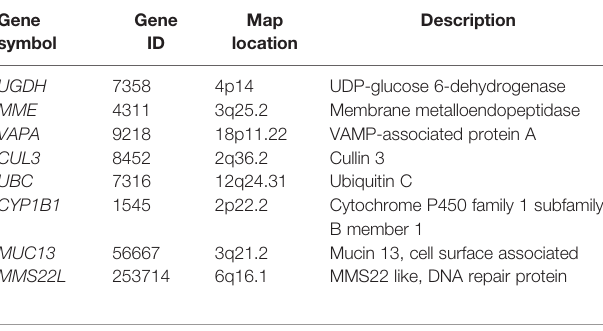
TABLE 1 | Identi fi cation of eight potentially related genes associated with chemoradiotherapy ef fi cacy: UGDH , VAPA , MME , CUL3 , UBC , CYP1B1 , MUC13 , and MMS22L .